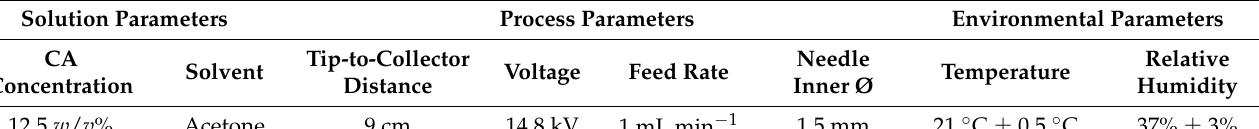
Table 1. Solution, process, and environmental parameters that were used during the electrospinning of CA solution. Solution Parameters Process Parameters Environmental Parameters Tip-to-Collector CA Concentration Solvent Distance